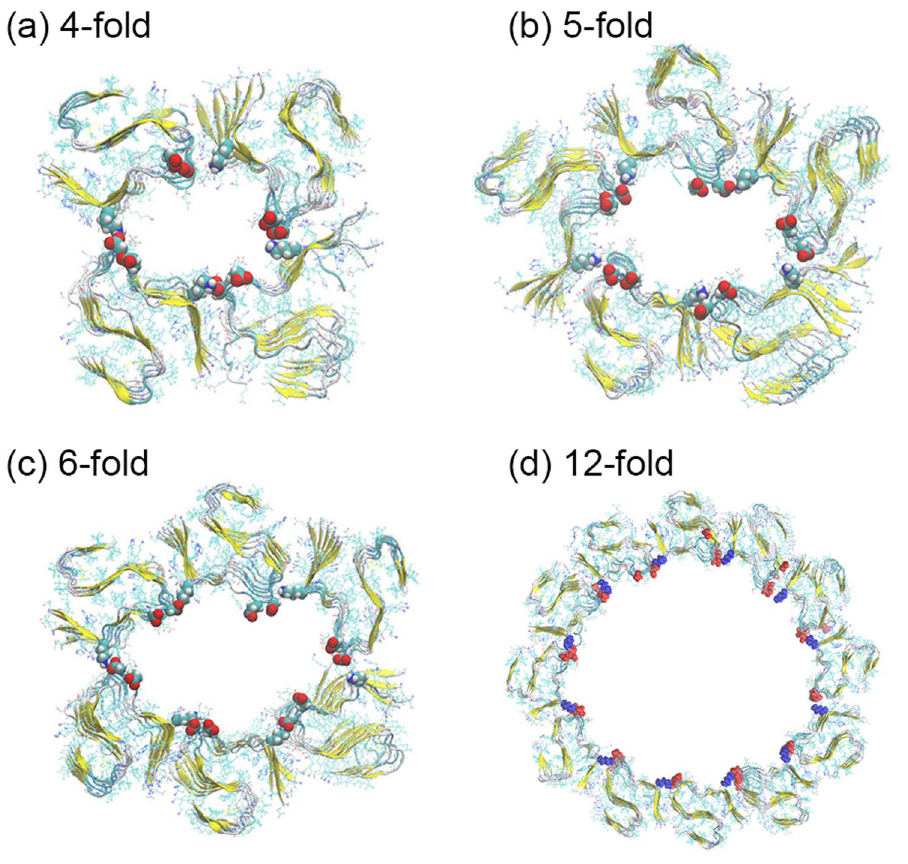
Figure 6. Final conformations of A β 11–42 N-fold fibril models after molecular dynamics simulations of 200 ns (50 ns in the case of the 12-fold model). The side chains of K16, E22 and D23 are shown as vdW